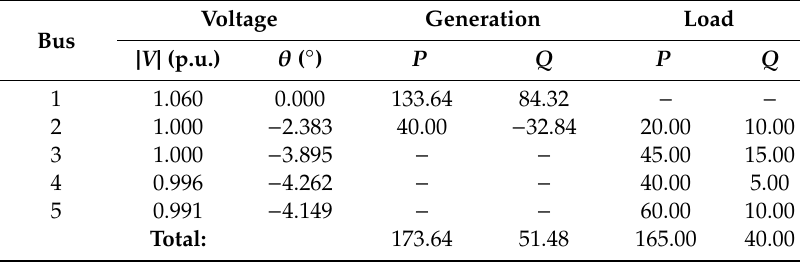
Table A3. Results of the mixed AC / DC PF calculations in Case 2. AC bus data.